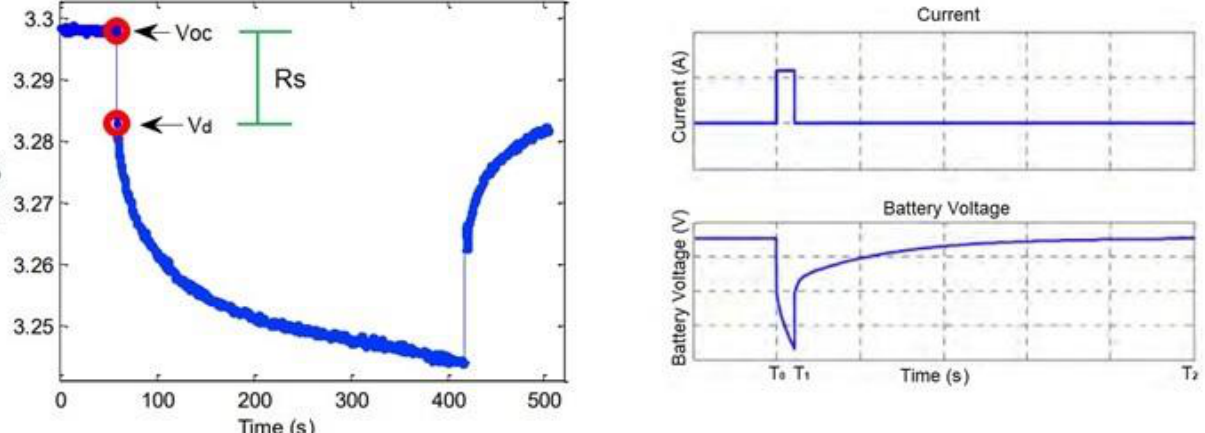
Figure 3. Measured voltage and current from the pulse discharge test.